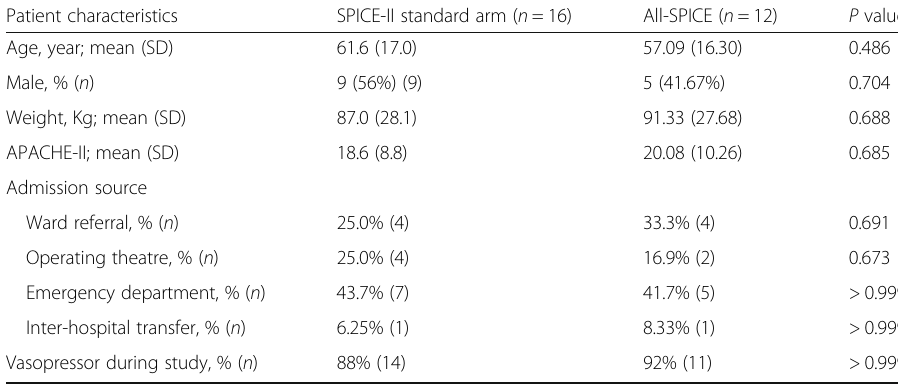
Table 2 Patient characteristics and demographic data Patient characteristics